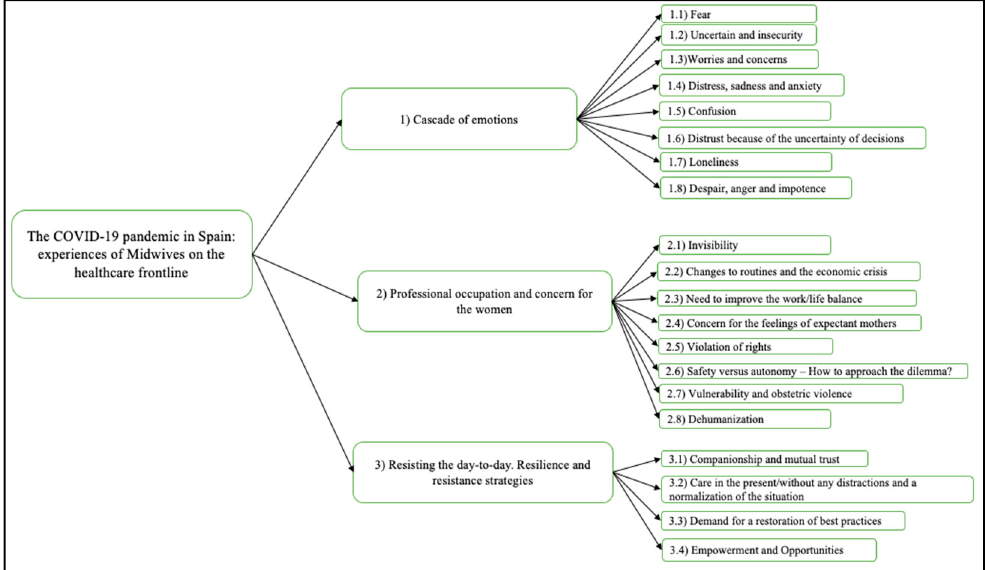
Figure 2. Categories based on our analysis of the transcriptions.